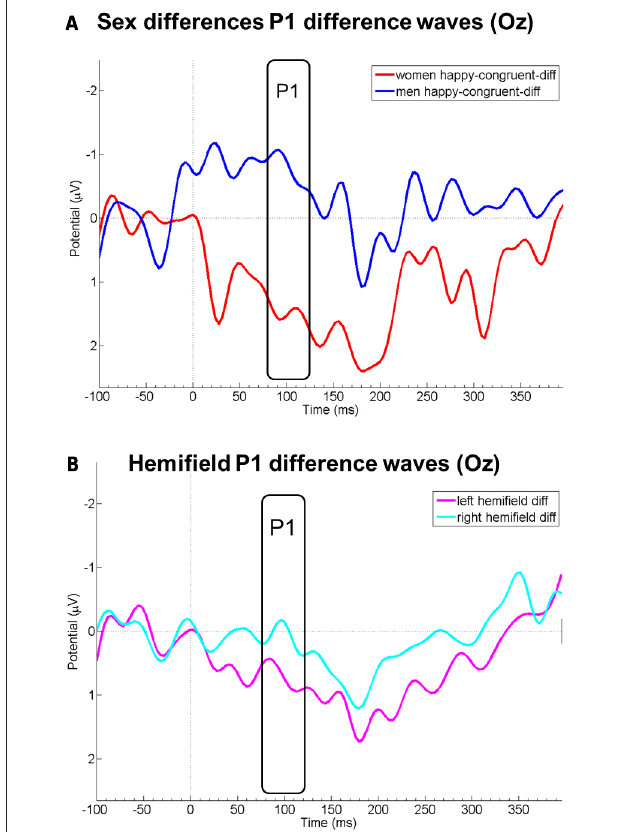
FIGURE 2 | Panel (A) displays EEG courses at electrode Oz of the difference wave amplitudes of the condition happy-congruent minus neutral for women (red) and men (blue). Panel (B) displays P1 difference wave amplitudes at Oz merged for all conditions in which the emotional face was presented in the left (pink) and right (light blue) visual hemifield. Negative is drawn upward per convention. The rectangles denote probe P1 analysis time